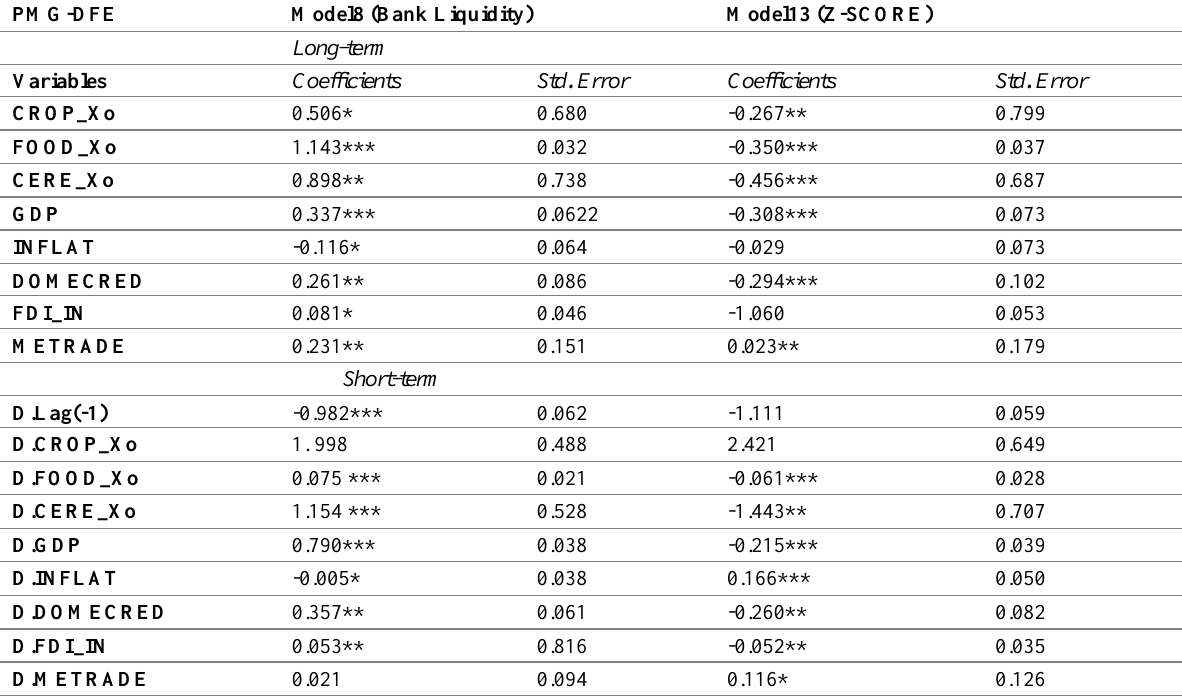
Table 6: ARDL-DFE